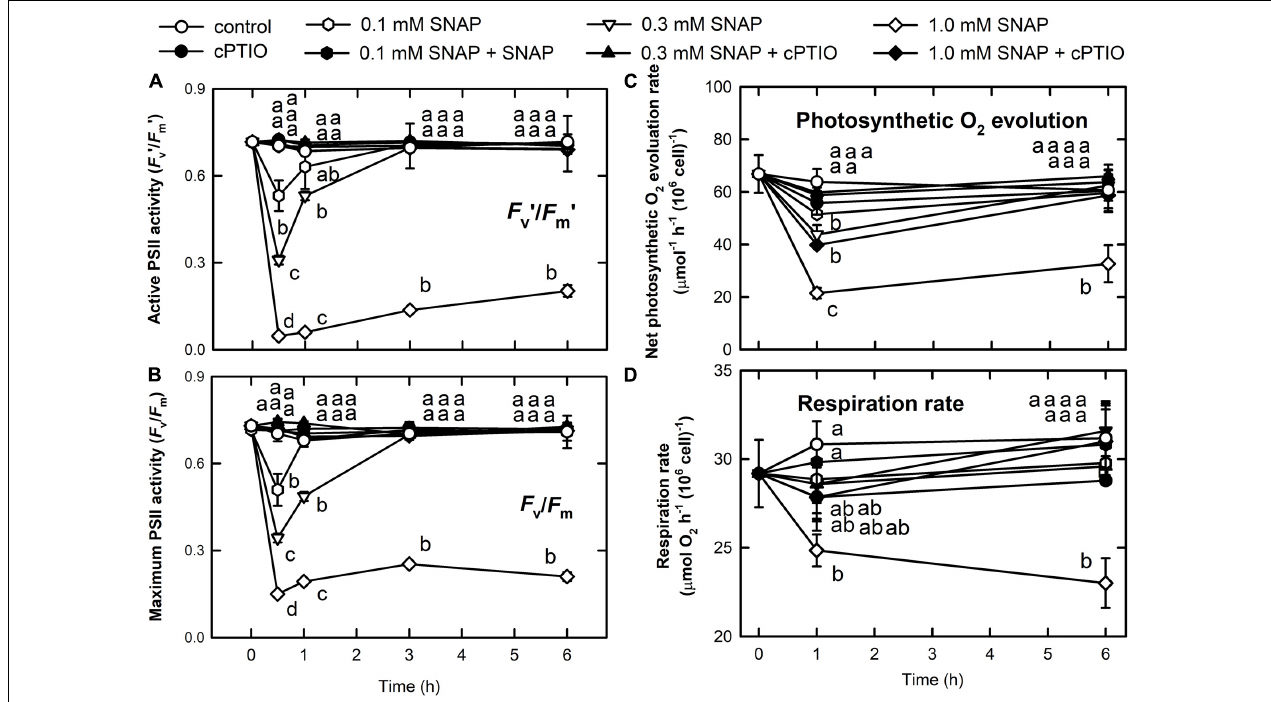
FIGURE 2 | Changes in photosynthetic activity and respiration rate in response to NO. The active ( F v ’/ F m ’) (A) and maximum ( F v / F m ) (B) PSII activity, photosynthetic O 2 evolution rate (C) , and respiration rate (D) in C. reinhardtii after exposure to 0.1, 0.3, or 1.0 mM SNAP in the presence or absence of 0.4 mM cPTIO. Data are expressed as the mean ± SD ( n = 3). Different symbols indicate significant differences between treatments (Scheffe’s test, P < 0.05).